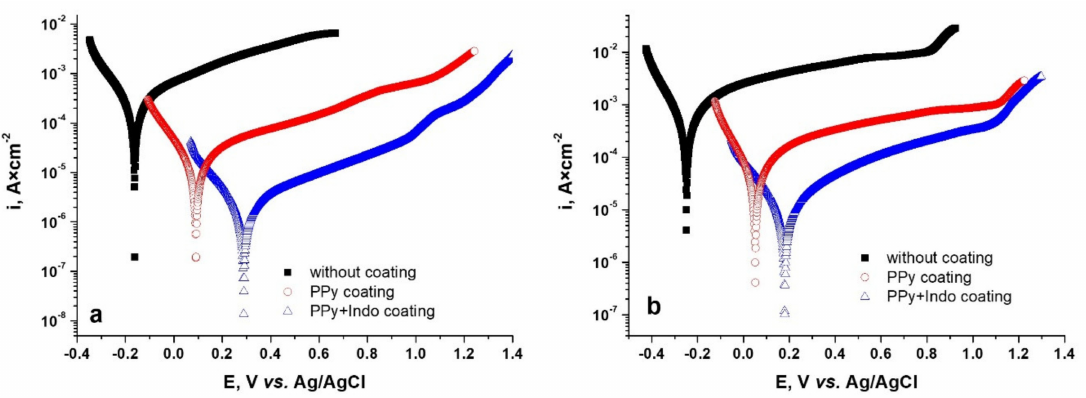
Figure 10. Polarization curves for uncoated and PPy or PPy-Indo coated WBC ( a ) and Hera ( b ) CoCr based alloys in Tani-Zuchi artificial saliva.